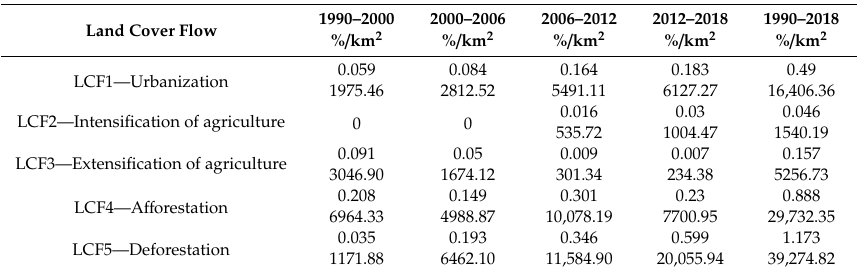
Table 6. Land cover flow in